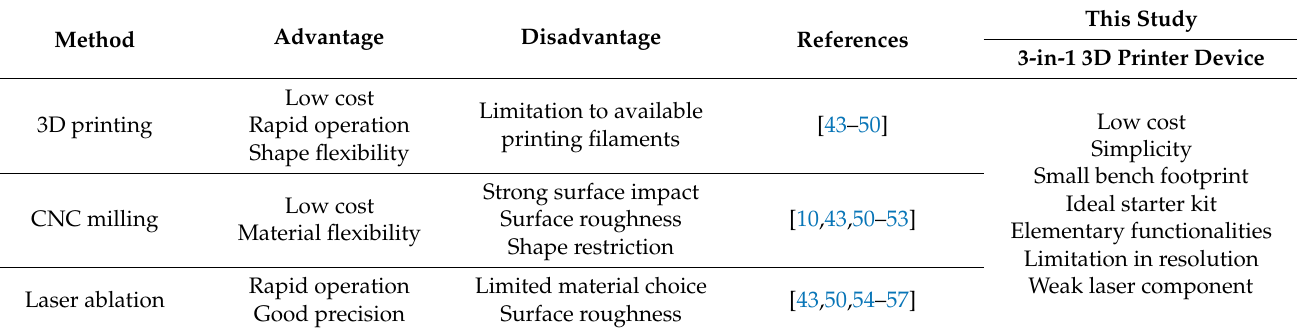
Table 4. Advantages and disadvantages of the fabrication of microfluidic microchannel fabrication via 3D printing, CNC milling and laser ablation and the benefits and drawbacks of the joint availability of the toolset in a low-cost 3-in-1 3D printer